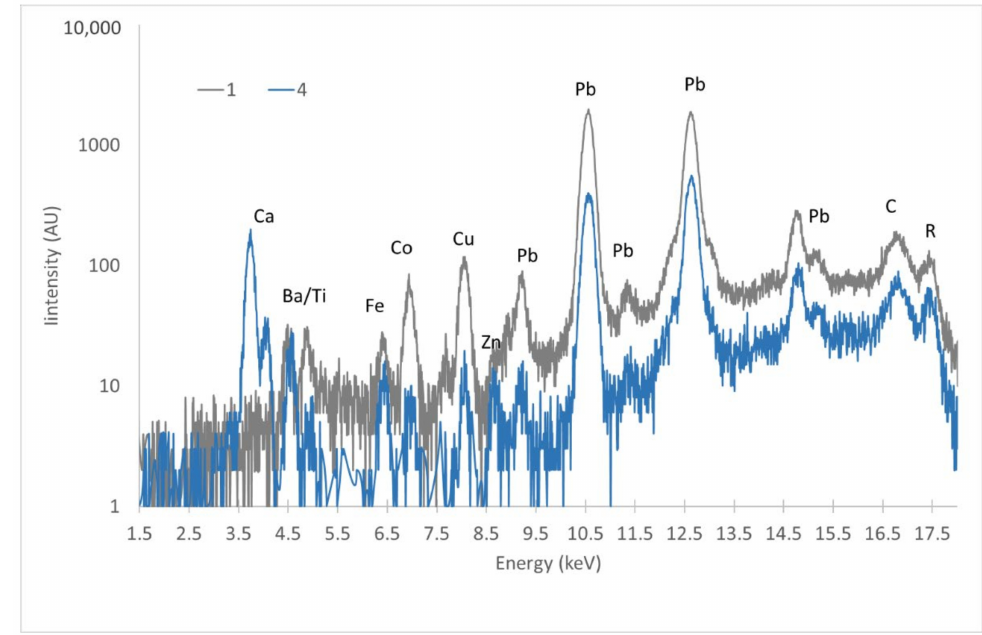
Figure 5. Comparison of XRF spectra in logarithmic scale for the original (1) and restored (4) areas on the front of the